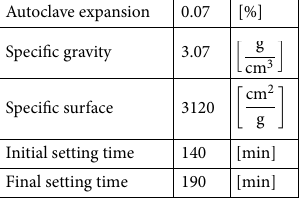
Table 1. The physical characteristics of cement.